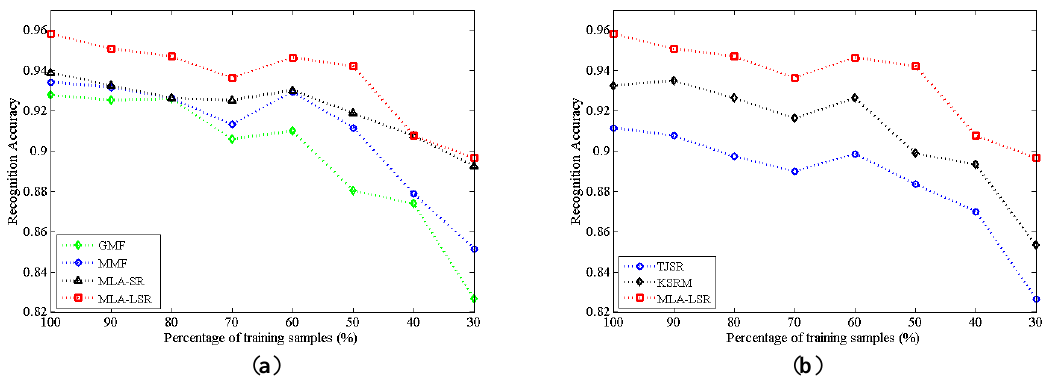
Figure 12. The recognition accuracy across the size of